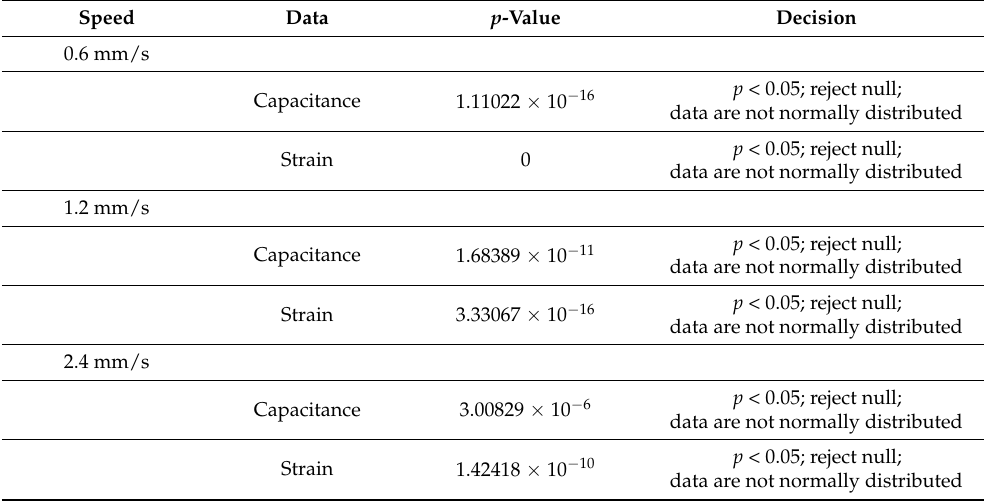
Table 1. Results of the Shapiro–Wilk Test of Normality for the Quasi-Static